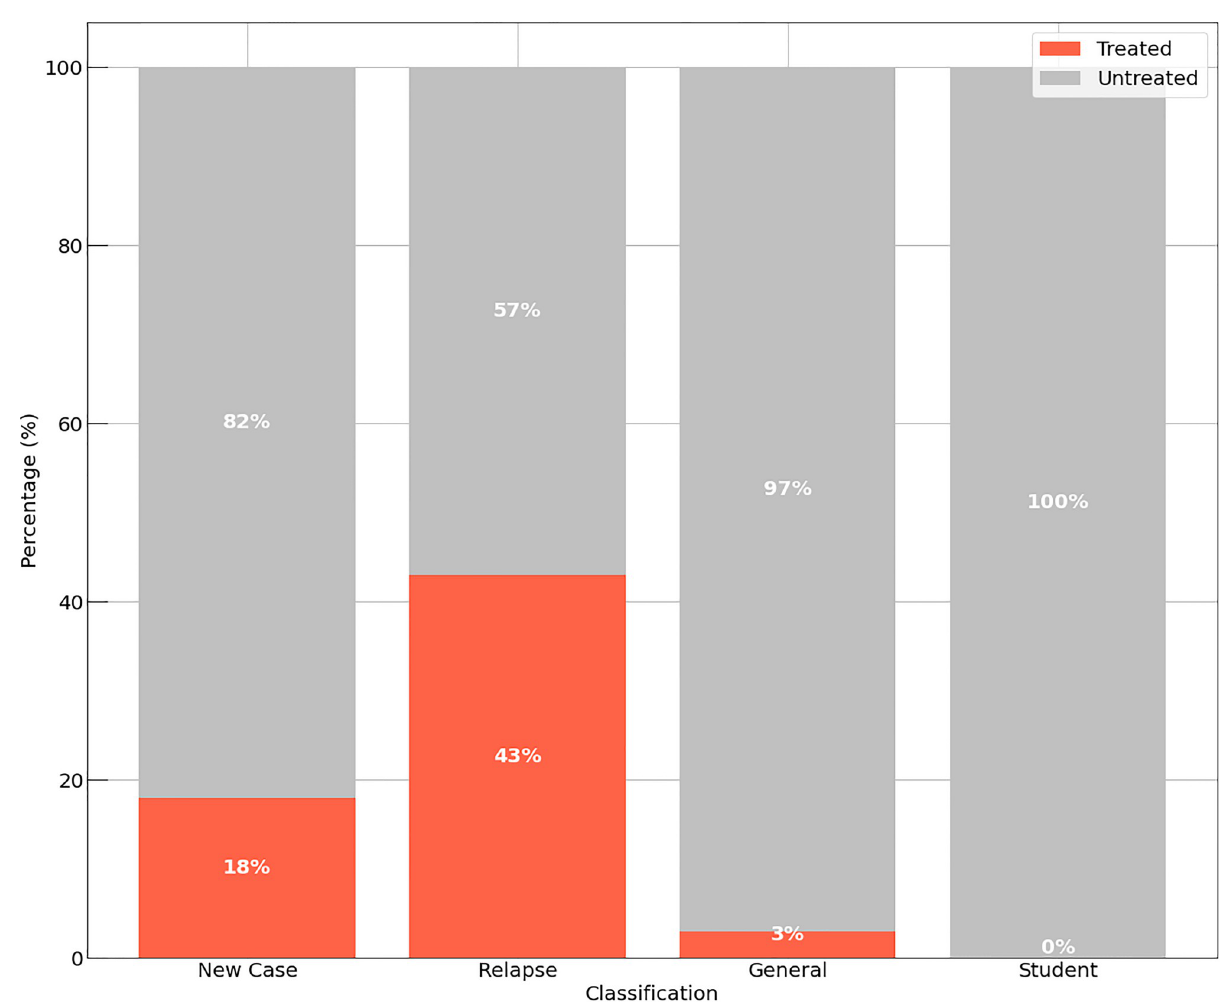
Table 4. The obtained data were used as input data in ELECTRE II and consequently displayed in the data visualization